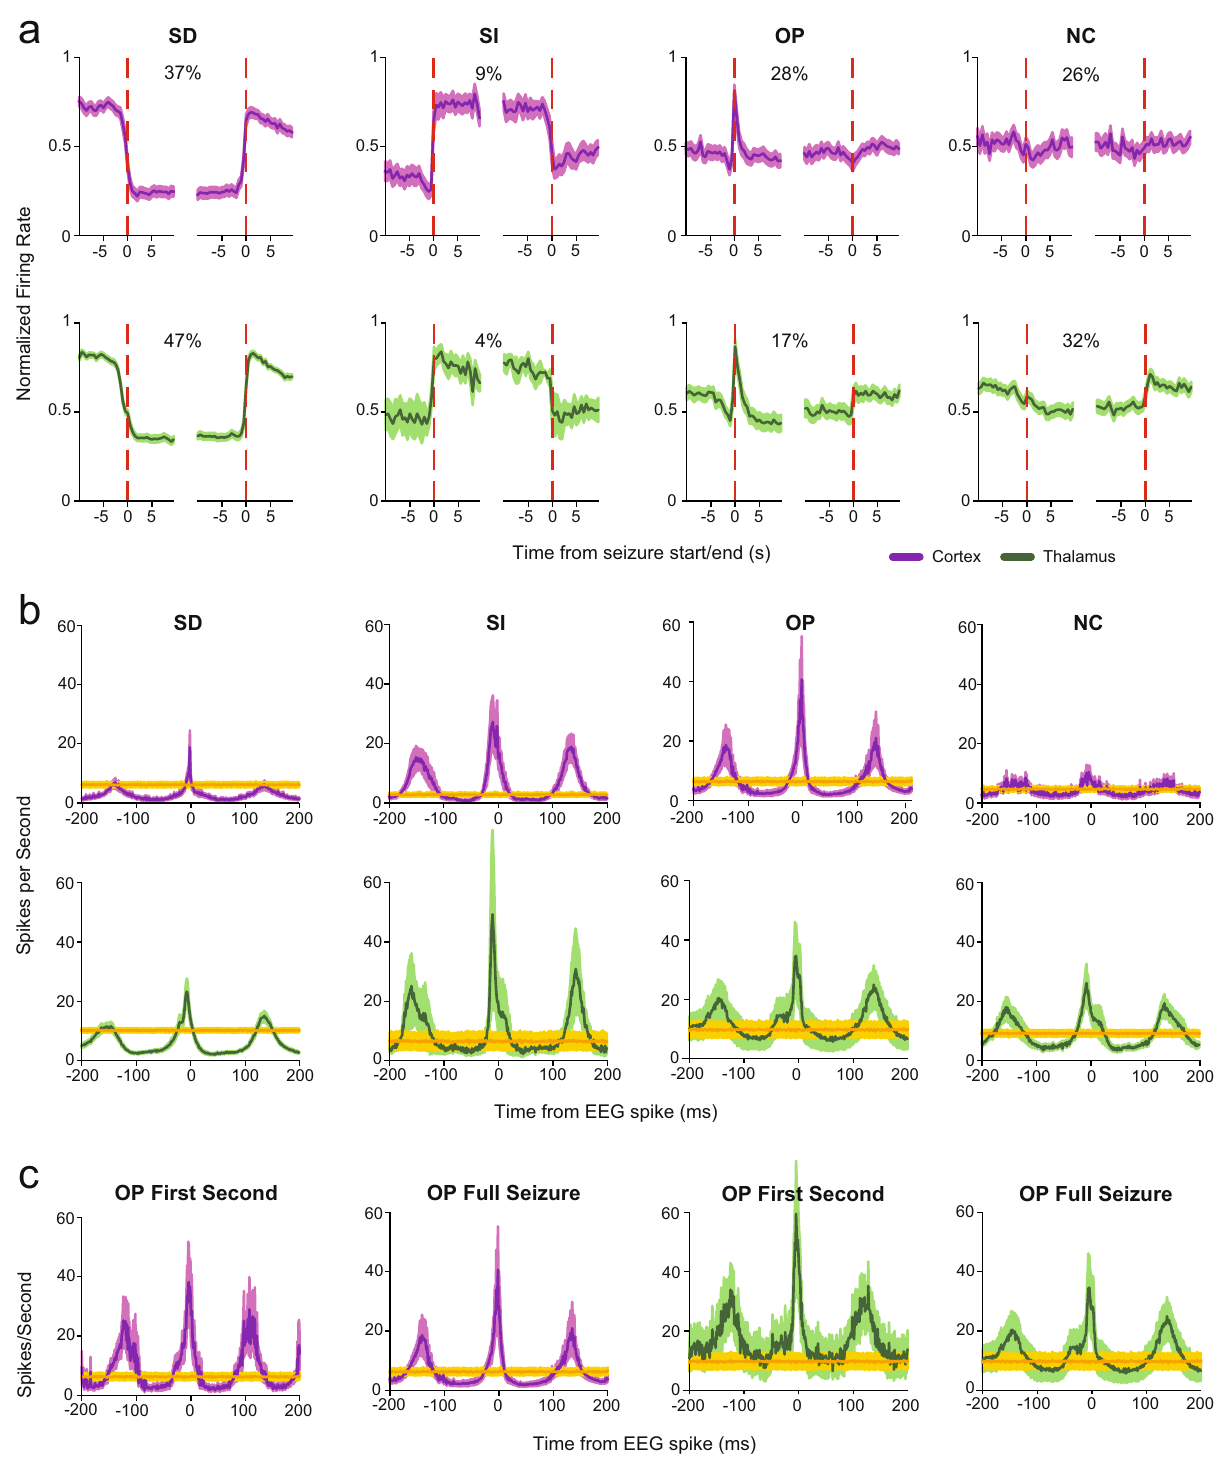
Fig. 5 | Four distinct fi ring patterns of cortical and thalamic neurons during absenceseizures.a Firingratesin0.5sbins(scaledforeachneuronrelativetototal range of fi ring in visualized period, see Methods) for each group of neurons showing the distinctive dynamics around seizure onset/offset from which their names are derived: SD sustained decrease ( n neurons=59 cortex, 76 thalamus), SI sustained increase ( n neurons=15 cortex, 7 thalamus), OP onset peak ( n neu- rons=44 cortex, 27thalamus),NC no change( n neurons=41cortex,52thalamus). Alsoindicatedisthepercentageofallneuronsineachgroup. b Meandistributionof action potentials in 1ms bins around EEG spikes (time 0)s of spike-wave cycles for the same groups. Oscillations within each cycle include periods of fi ring that are